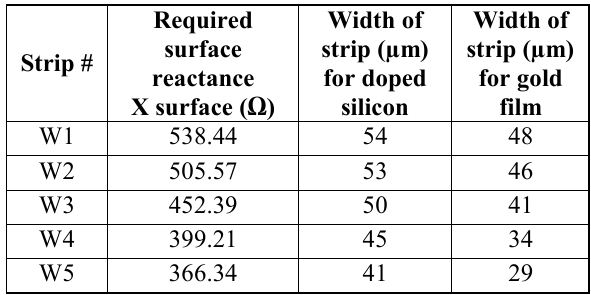
Table 1: Width distribution of both the doped silicon and gold